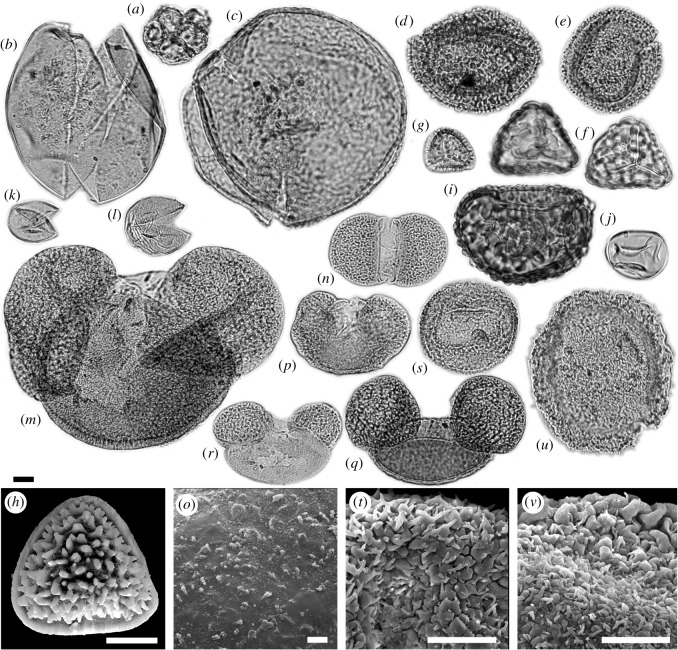
LM and SEM micrographs of algae, fern and fern allies, and gymnosperm palynomorphs. (a) Botryococcus sp. cf. B. braunii, (b) Spirogyra sp. 1/Ovoidites elongatus, (c) Spirogyra sp. 2/Cycloovoidites cyclus, (d–e) Osmunda sp., (d) EV, (e) PV. (f) Cryptogramma vel Cheilanthes sp./Cryptogrammosporis magnoides, PV. (g–h) Pteris sp./Polypodiaceoisporites corrutoratus, (g) PV, (h) DV. (i) Davalliaceae vel Polypodiaceae gen. indet./Verrucatosporites alienus, EV. (j) Monolete spore fam. indet./Leavigatosporites haardti, EV. (k–l) Papillate Cupressaceae pollen/Inaperturopollenites hiatus. (m) Abies sp., EV. (n–o) Cathaya sp., (n) PV, (o) SEM detail, nanoechinate sculpturing of cappa (PRV). (p) Cedrus sp., EV. (q) Pinus subgenus Pinus sp., EV. (r) Pinus subgenus Strobus sp., EV. (s–t) Tsuga sp. 1, (s) PV, (t) monosaccus and corpus detail, PRV. (u–v) Tsuga sp. 2, (u) PV, (v) monosaccus and corpus detail, PRV. Equatorial view (EV), polar view (PV), distal view (DV), proximal view (PRV). Scale bars 10 µm (LM, h,t,v), 1 µm (o).